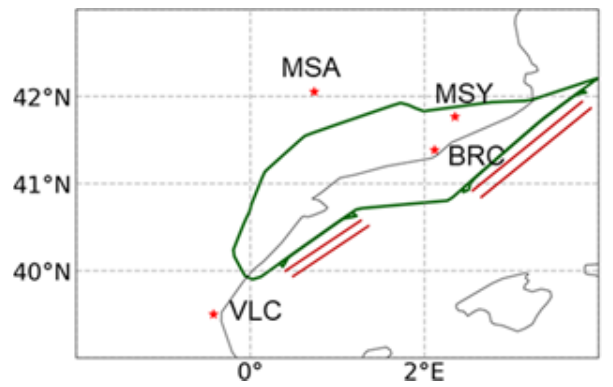
Figure 24. Detail of E-EU-F09 flight track (in green) and the ground-based stations with coordinated remote sensing measure- ments in the vicinity: Montseny (MSY), Sierra del Montsec (MSA), Burjassot (VLC), and Barcelona (BRC). Red lines indicate the po- sition of the HALO